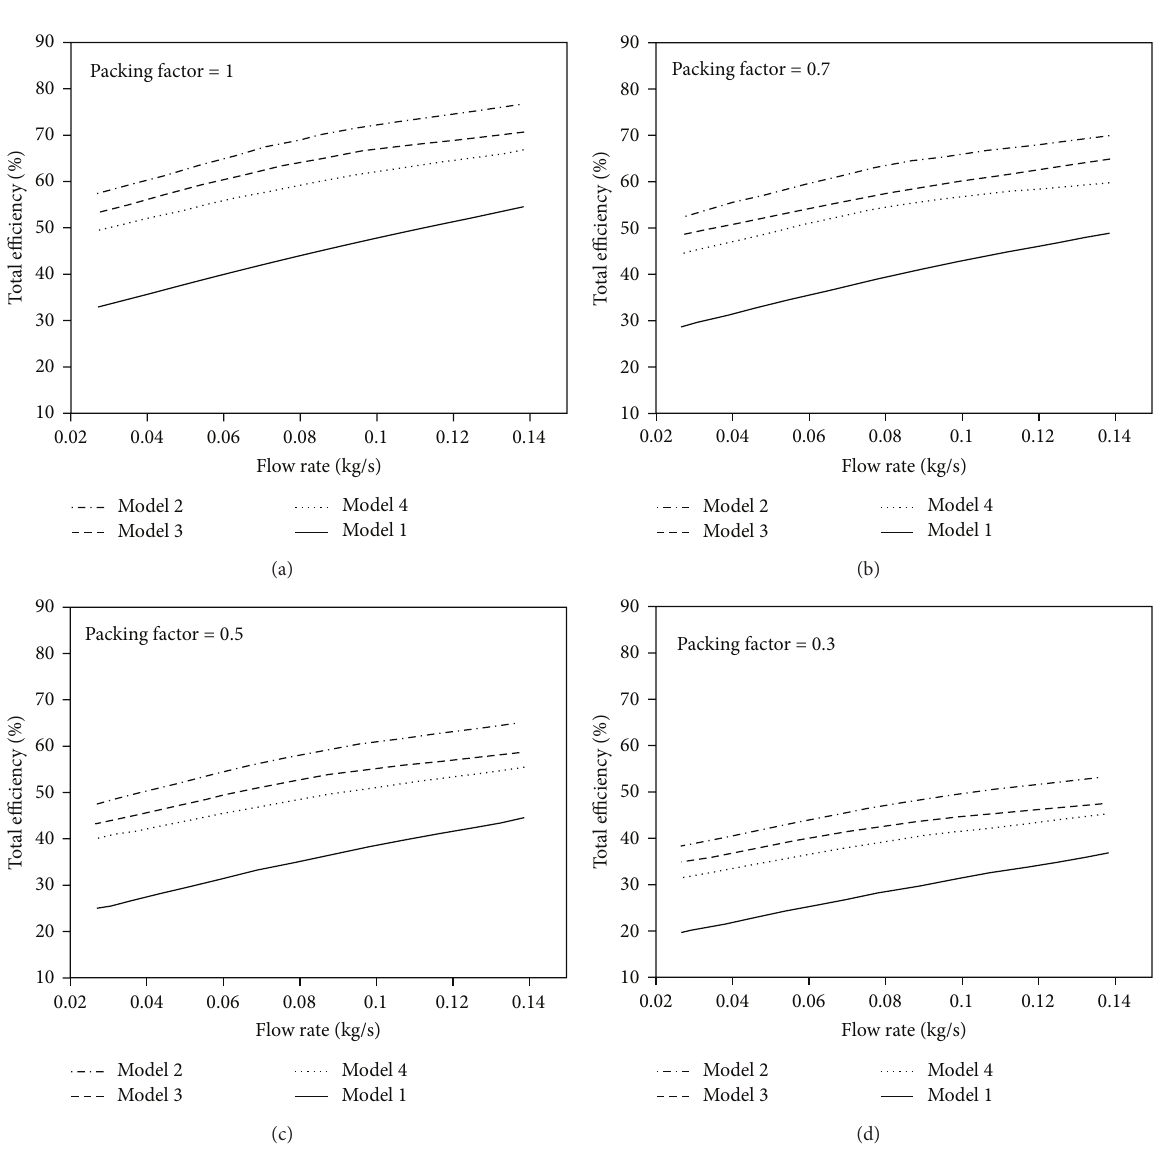
Figure 3: Total efficiencies of the four models at different packing factors.